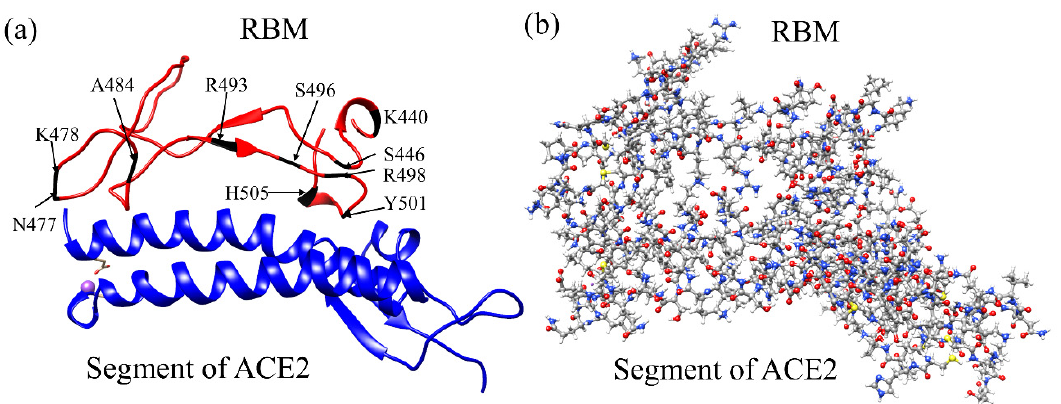
Figure 1. The RBM-ACE2 interface model. ( a ) Ribbon structure showing the interface between the RBM and segment of ACE2. Ten mutated AAs of the RBM in OV are marked. ( b ) The ball and stick structure of the same model in ( a ): Grey: C; red: O, blue: N; and white: H. In the WT interface model, there are 1102 atoms in RBM, 1822 atoms in ACE2 segment, and 6 Na + ions, with a total of 2930 atoms. In OV interface model, there are 1141 atoms in RBM, 1822 atoms in ACE2 segment, and 1 Na + ions with a total of 2964 atoms.